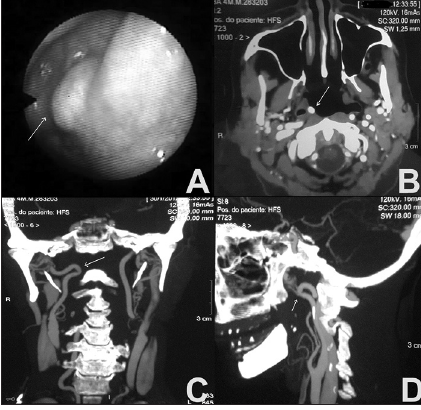
Figure 1. A: Nasal endoscopy image showing a pulsating mass in the lateral recess of the nasopharynx. B, C, D: Contrast-enhanced CT scan of the neck; axial, coronal, and sagittal views, respectively, showing a kinked right internal carotid